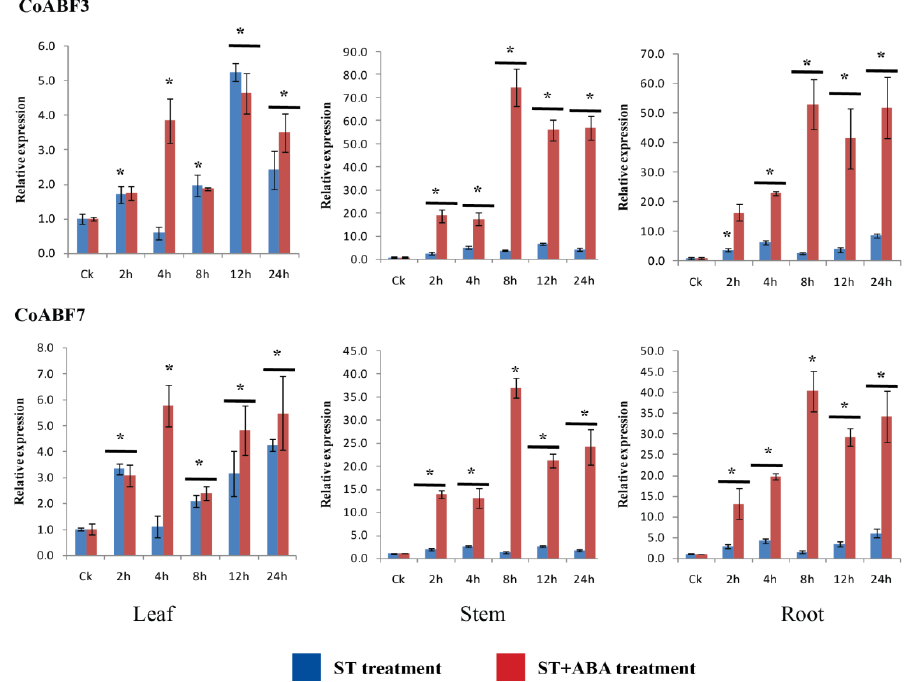
Figure 7. Expression pattern of CoABF3 and CoABF7 measured in jute tissues under ST (200 mM) and ST+ABA (200 mM ST + 10 µmol/L ABA). Data represent the means of three independent repli- cates ± standard deviation (SD). Asterisks denote statistically significant differences (* p ≤ 0.05) com- pared to the control (CK), respectively.